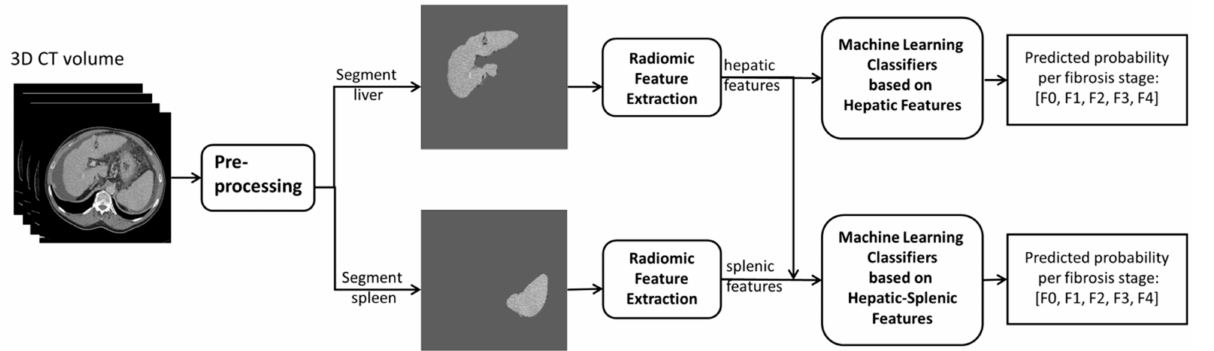
Figure 2. Overall algorithm scheme. First, the computed tomography (CT) volume was preprocessed; then, the liver and spleen were segmented as the region of interest. The radiomic features were extracted from the segmented liver and spleen. The machine learning classifiers were trained by hepatic features and hepatic–splenic features, respectively, to predict the probability array of liver fibrosis stages, namely